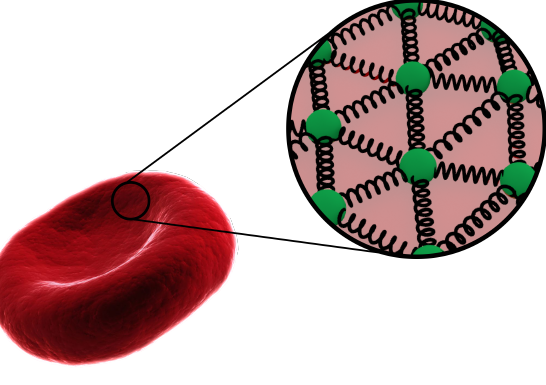
Figure 2. Schematic of the MSM representing the network of interconnected particles via spring